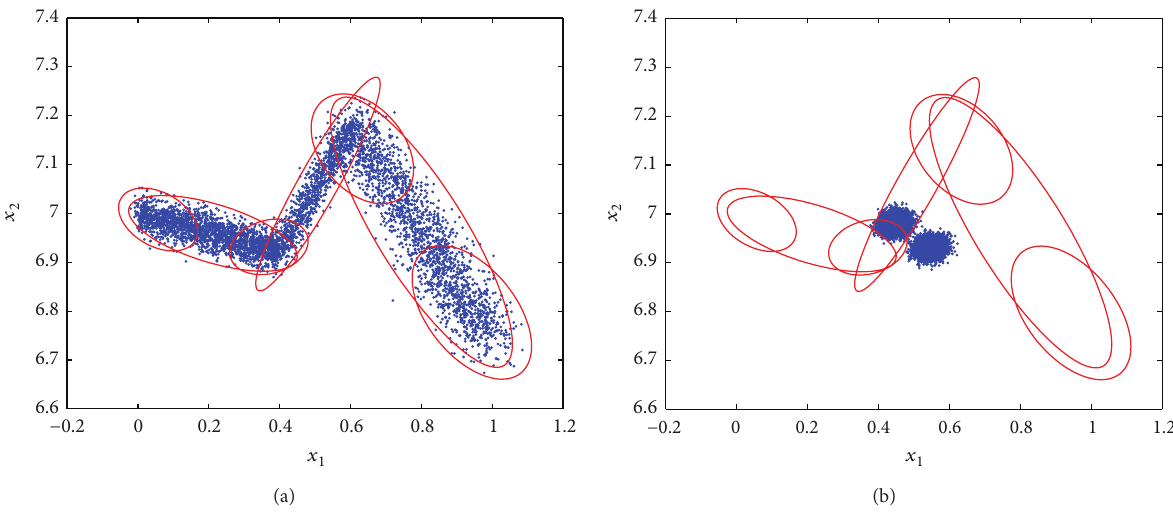
Figure 4: Training data (a) and test data (b) with a change in mean. The identified GMM model is shown in red.